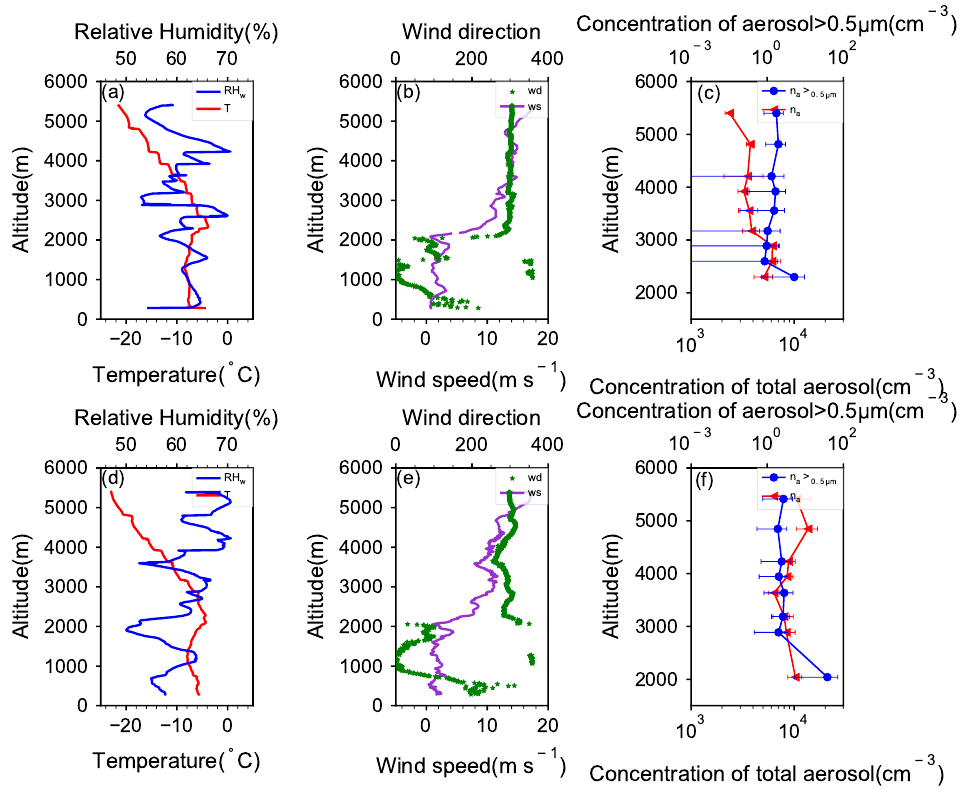
Figure 6. Vertical distributions of the meteorological parameters during the ascent stage ( a – c ) and the descent stage ( d – f ).